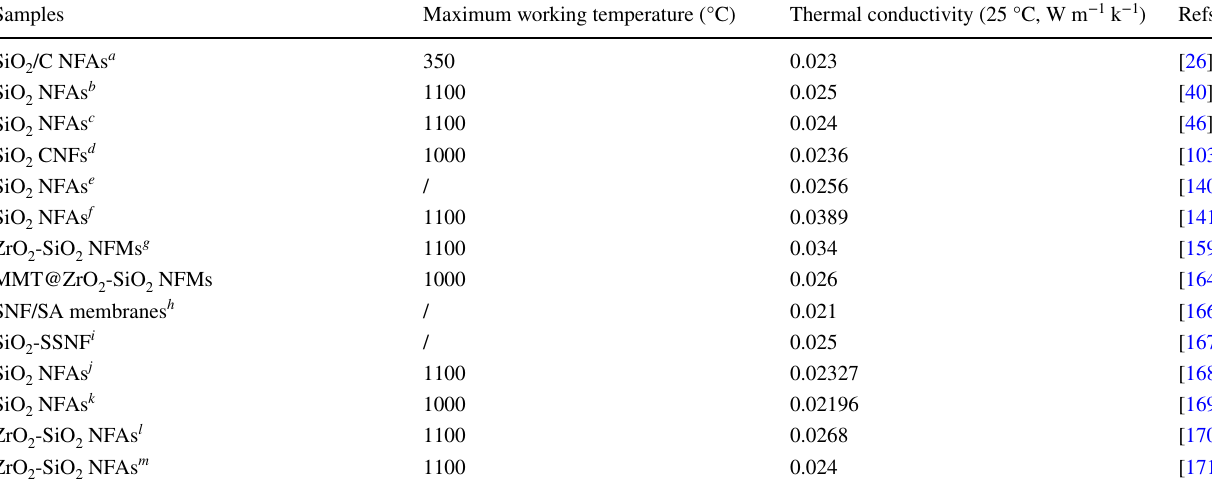
Table 2 Comparison of properties of electrospun SiO 2 nanofibrous materials for thermal insulation